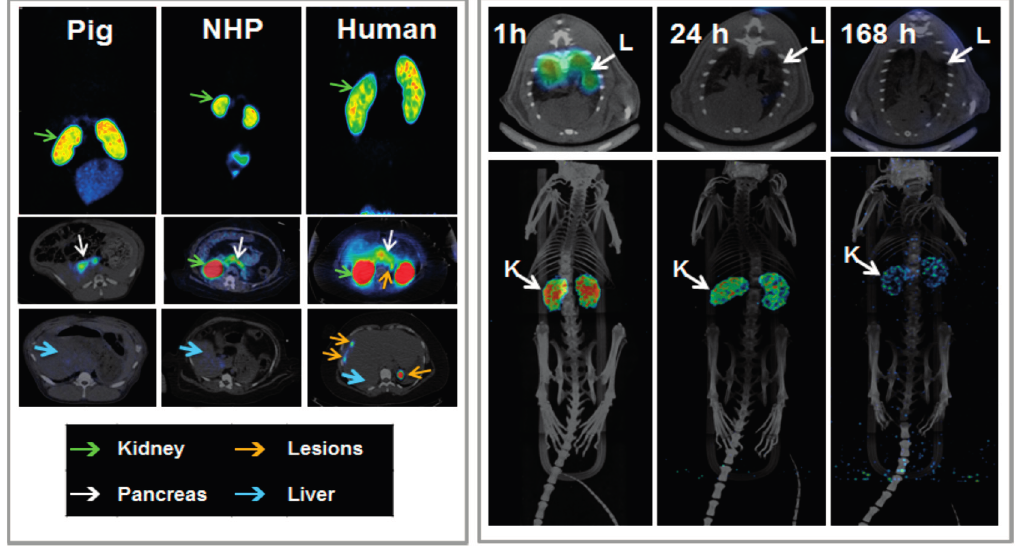
Figure 20. ( Left panel ) In vivo biodistribution of [ 68 Ga]Ga-DO3A-VS-Cys 4 °-Exendin-4 as analyzed by PET-CT imaging in the pig (0.025 µg/kg; 60 min), non-human primate (NHP) (0.01 µg/kg; 90 min), and human (0.17 µg/kg; 40 min, 100 min and 120 min). The pancreas ( white arrow ) was delineated within 10 min post injection in all species. The low hepatic uptake ( blue arrow ) shows the potential for outlining insulinoma tumor metastasis ( orange arrow , human images). The MIP coronal images demonstrate the highest uptake of the tracer in the kidneys (green arrow) in all species. ( Right panel ) Representative fused SPECT-CT images of [ 177 Lu]-DO3A-VS-Cys 40 -Exendin-4 in rats at different time points. Lungs could be outlined at 1 h p.i. and showed faster clearance in later time points ( upper panel ). MIP images of whole body scan showing dominance of kidneys as excretory organ of tracer ( lower panel